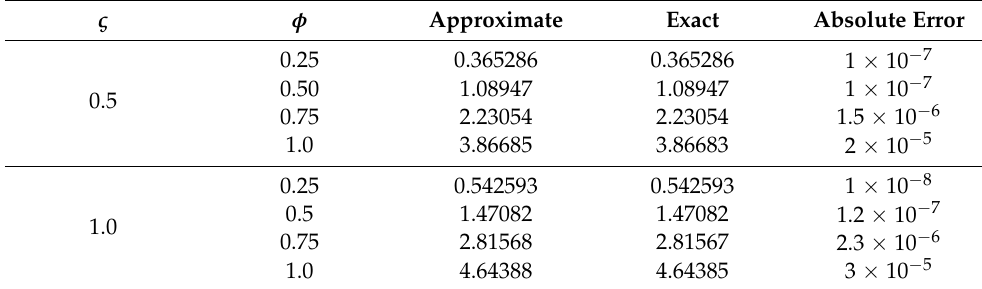
Figure 4. Graphical error between the approximate and precise results of ϑ ( ς , ξ , φ ) . Table 2. Absolute error between the approximate and exact solutions for Example